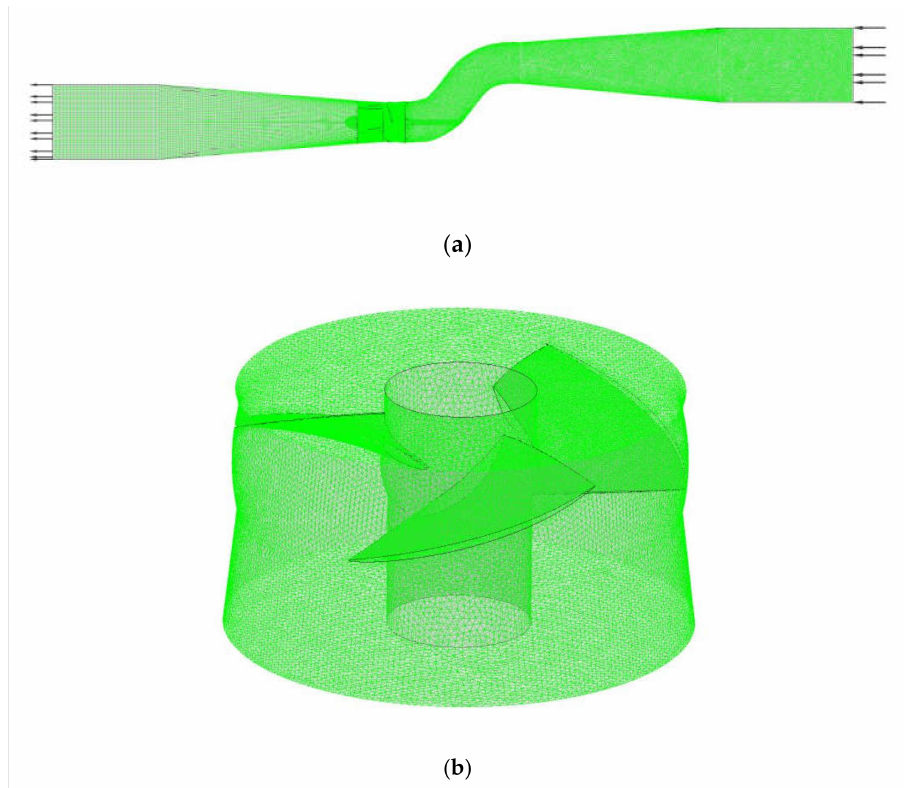
Figure 4. Grid division of the Fluid Domain. ( a ) The grids of S-type front shaft extension tubular pump device. ( b ) The grid of the impeller.